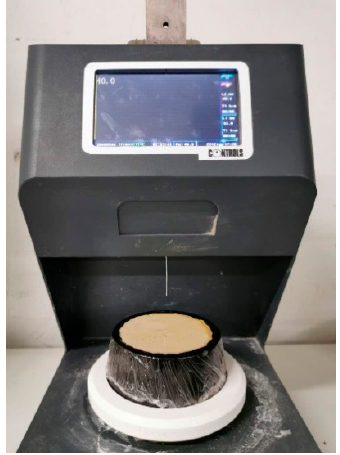
Figure 2. Automatically recording Vicat apparatus.